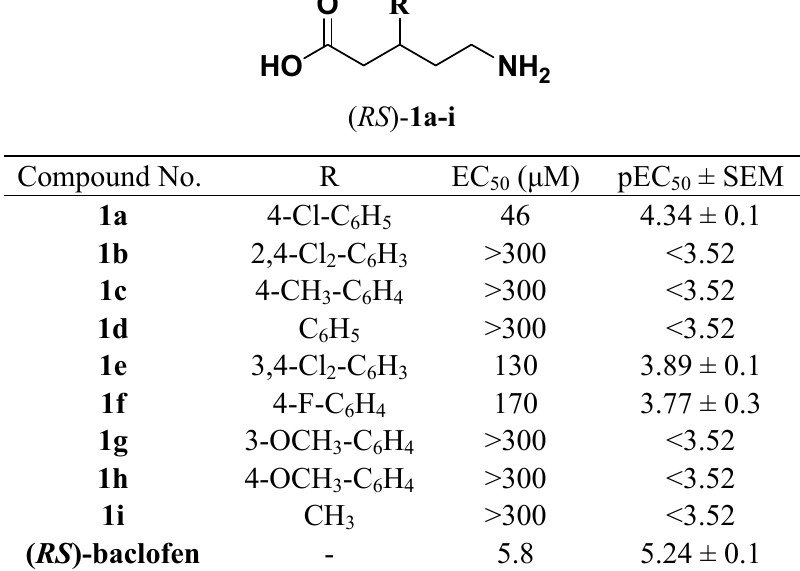
Figure 2. Concentration-response curves of compounds 1a , 1e , 1f and ( RS )-baclofen on wild type GABA R1b co-expressed with GABA R2 and the chimeric G protein G α q-z5. B B The curves are representative for the average pharmacological profile of the agonists. The Ca 2+ measurement assays were performed as described in the materials and methods